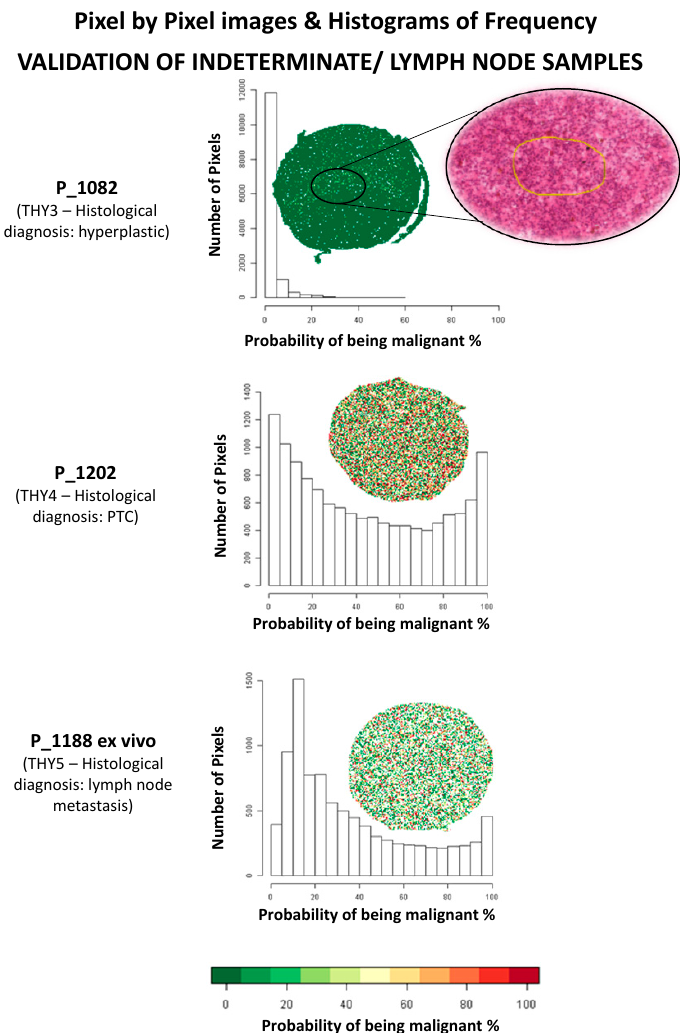
Figure 3. Validation set of indeterminate for malignancy (Thy3), suspicious (Thy4) cases, and metastatic lymph node. Pixel-by-pixel images and distribution of the probabilities of being malignant for each pixel in the MALDI-MSI